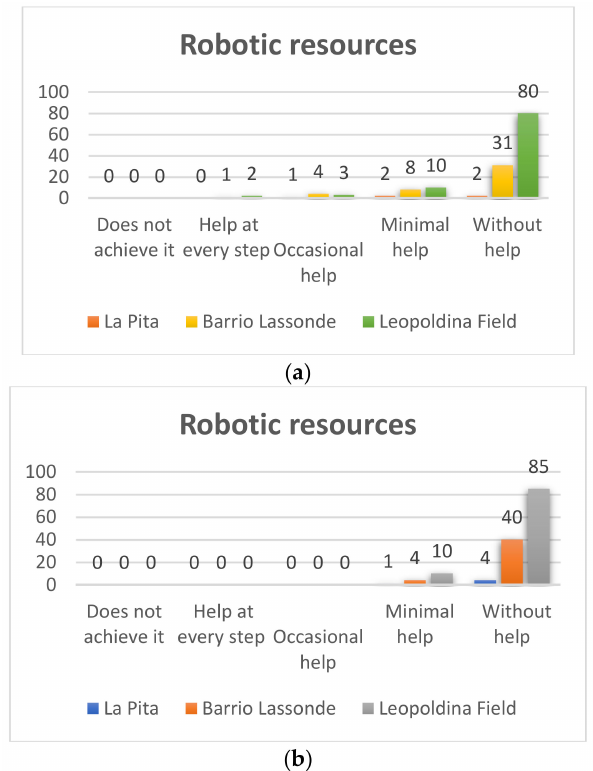
Figure 8. First grade robotic resources Pre-Test ( a ) and Post-Test ( b